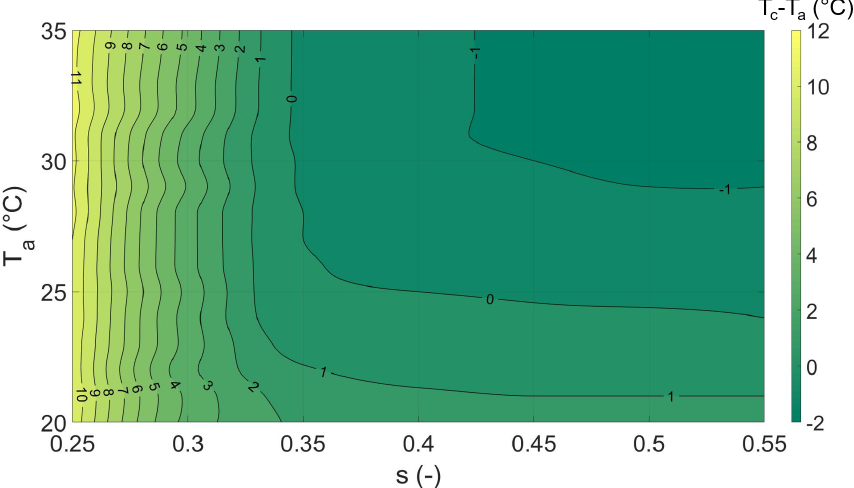
Figure 3. Canopy air temperature difference, T c − T a (colors and contour lines), as a function of soil moisture ( s ; x axis) and air temperature ( T a ; y axis) for a sandy loam. All other parameters are summarized in Table S2.